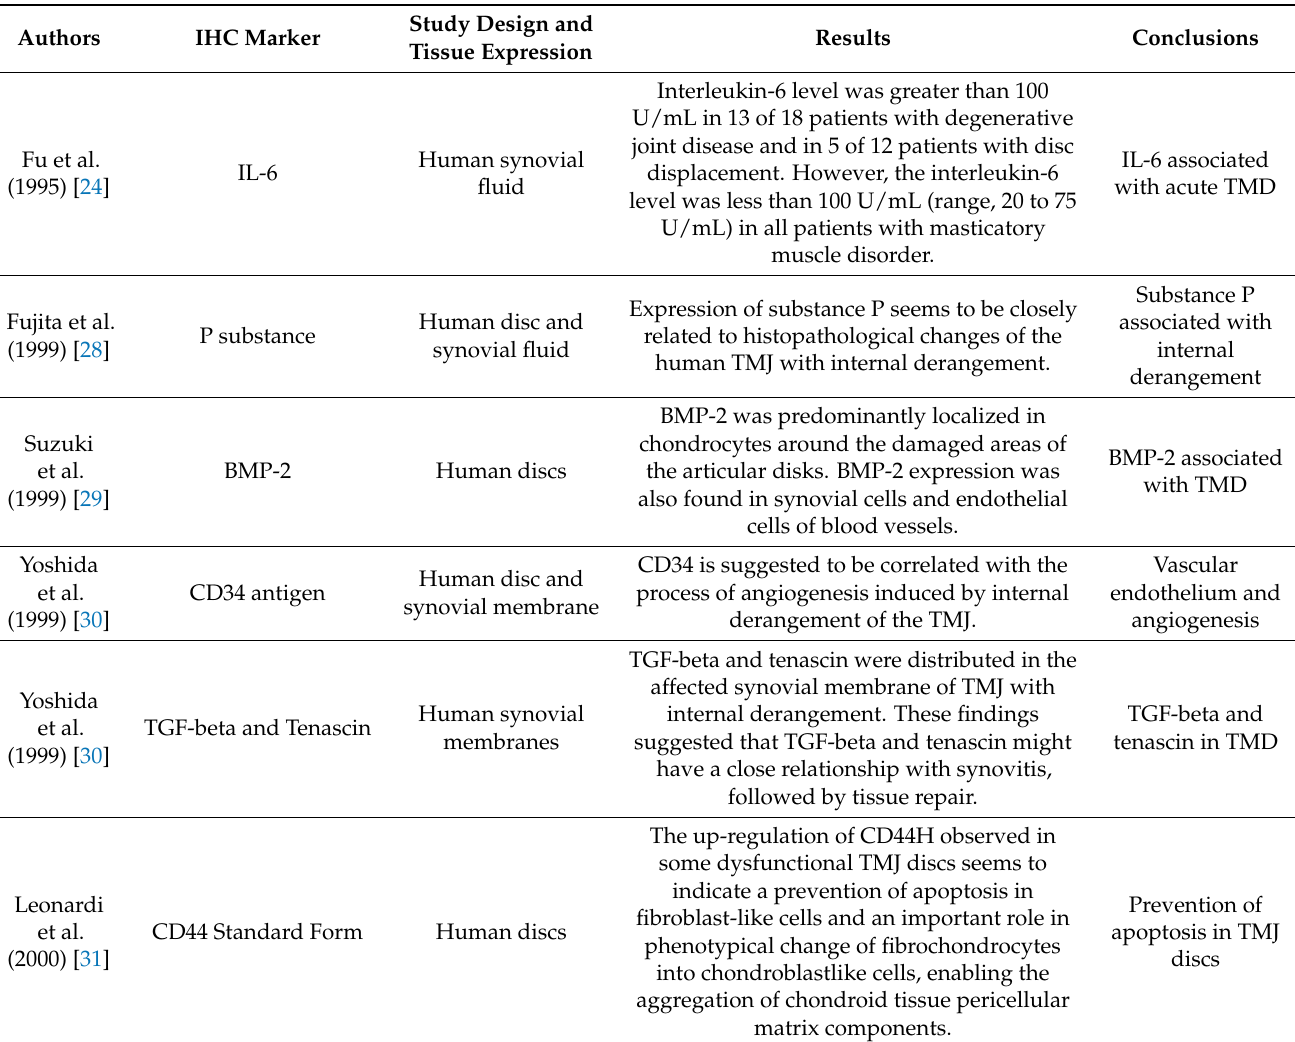
Table 2. Cytokines and Inflammatory Markers (Interleukins, TNF alpha, FasL, VEGF, IGF, NFKB, IFN-y, capsaicin, BMP-2,